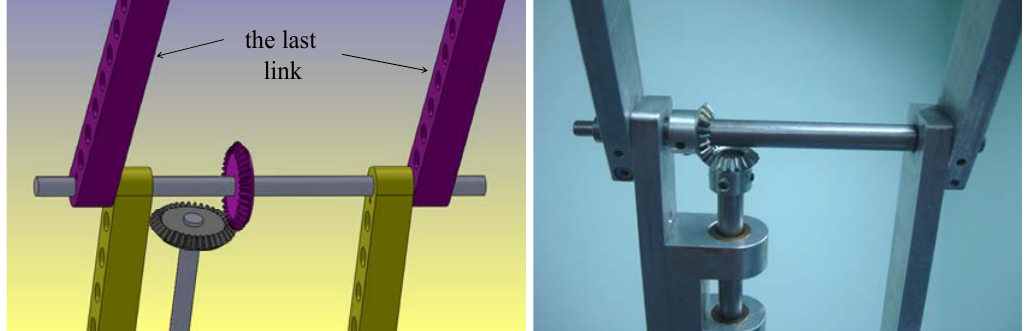
Figure 6. The last joint of the